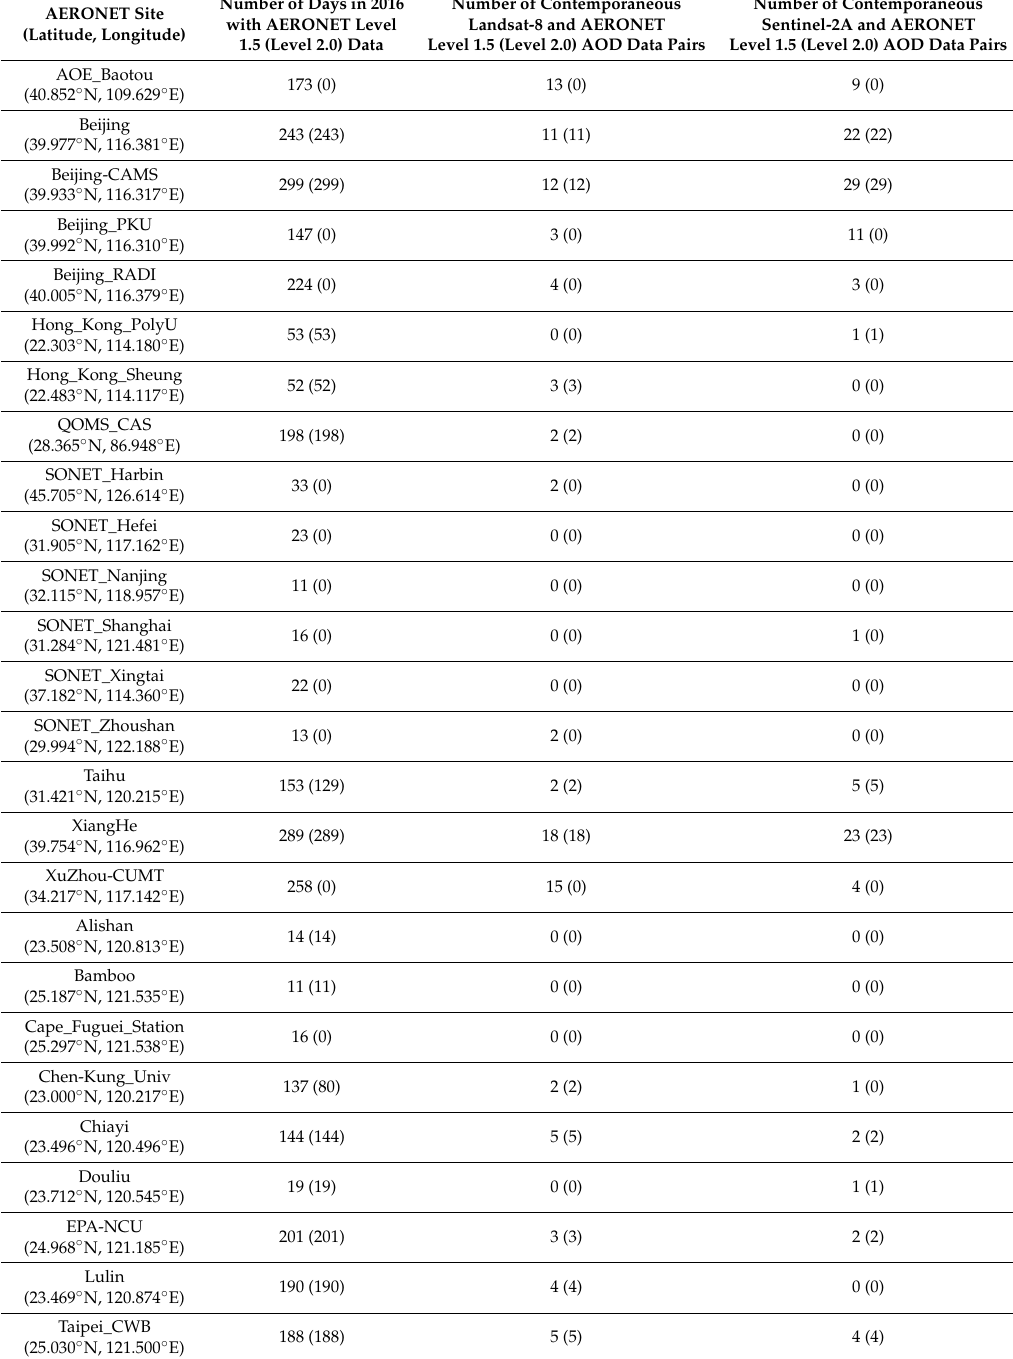
Table 2. Summary of the 26 urban AERONET sites (Figure 1), the number of days with 2016 AERONET data, and the number of contemporaneous LaSRC satellite AOD and AERONET AOD data pairs. Number of Contemporaneous Number of Days in 2016 AERONET Site with AERONET Level Landsat-8 and (Latitude, Longitude) 1.5 (Level 2.0) Data